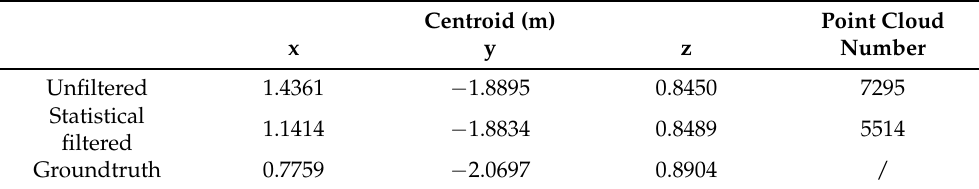
Table 3. Point cloud filtering in single batch.